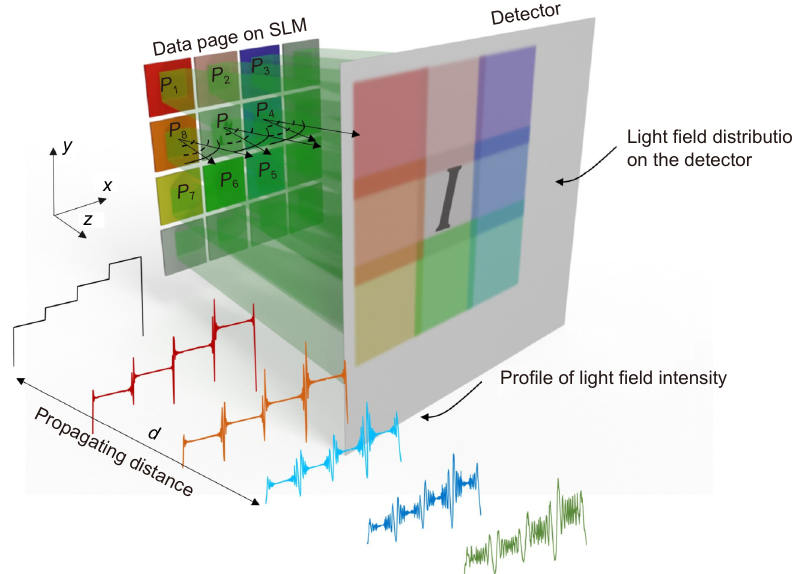
Fig. 2 | Simplified theoretical model of diffraction process in HDS